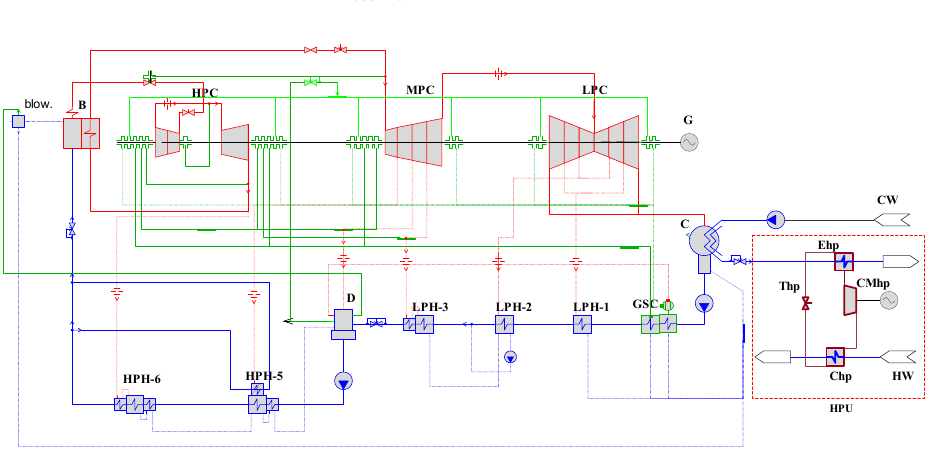
Figure 1. Calculation scheme of the mathematical model with the inclusion of a heat pump as part of the K-300-170 turbine unit: Blow—blowdown; B—boiler; HPC—high pressure cylinder; MPC—